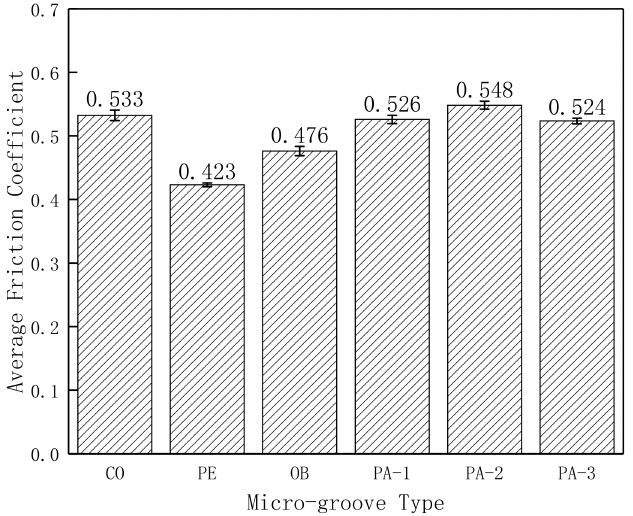
Figure 5. Average values of friction